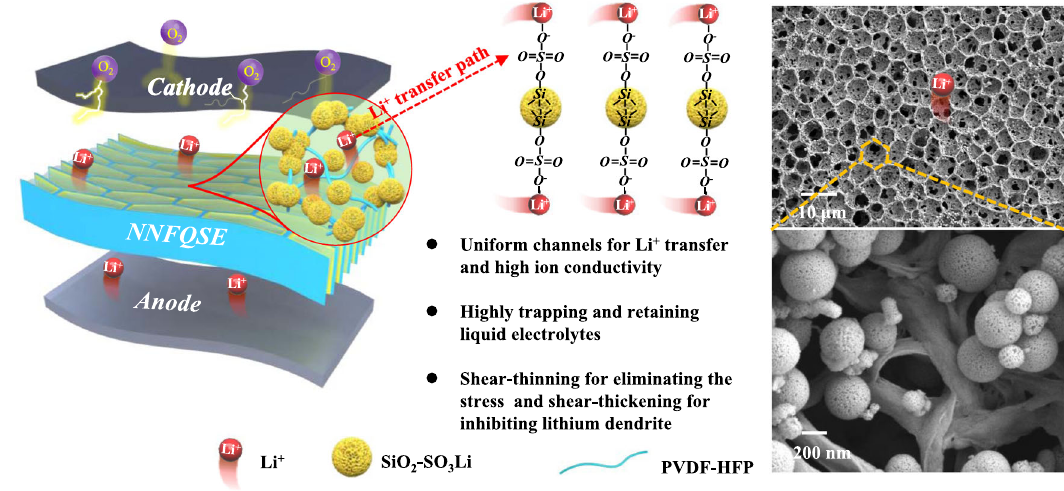
Fig. 1 | Schematic diagram of NNFQSE SiO 2 -SO 3 Li/PVDF-HFP with uniform Li + transport